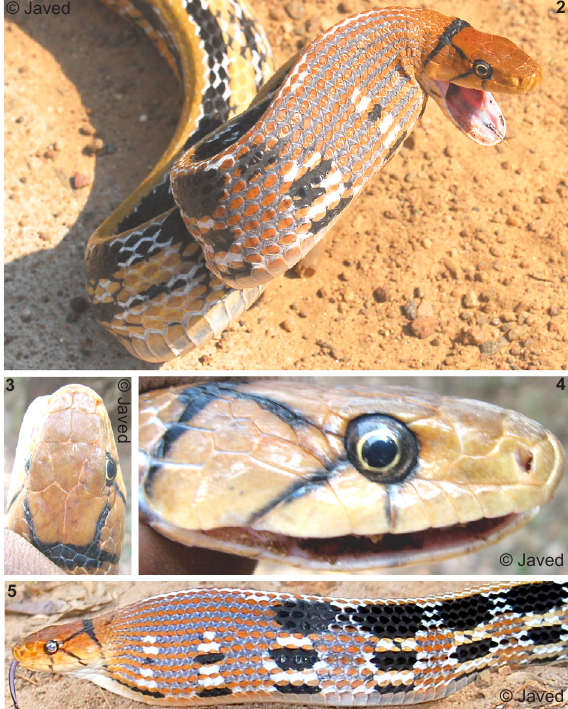
Images 2-5. Coelognathus radiatus. 2 - Dorsolateral aspect of C. radiatus (live, photo voucher-15) displaying defensive posture; 3 - Dorsal aspect of C. radiatus (live, photo voucher-16) head showing